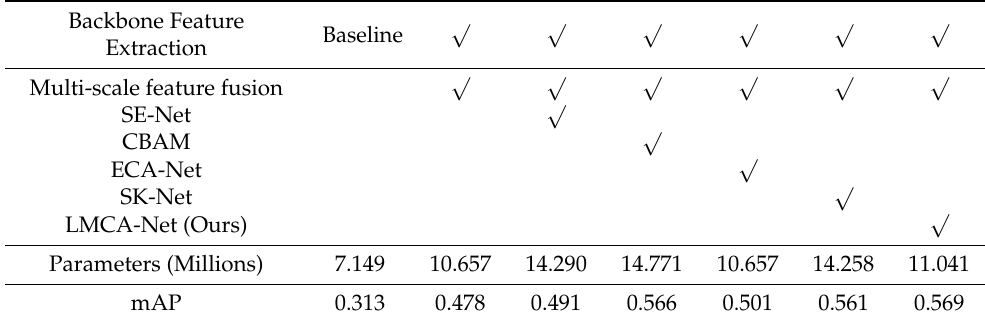
Table 10. The results of the ablation experiments using the attention module of the same dataset. Backbone Feature Baseline Extraction Multi-scale feature fusion